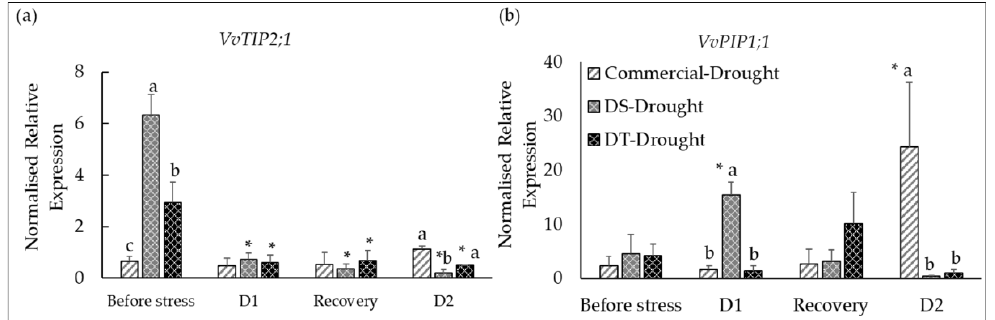
Figure 4. Changes in chlorophyll fluorescence parameters in dry-farmed and commercial clones at the peak of 1st and 2nd drought cycles. ( a ) Mesophyll conductance ( g m ), ( b ) maximum photochemical efficiency ( F v / F m ), ( c ) actual photochemical efficiency (Φ PSII ), ( d ) photochemical quenching coafficient ( qP ), ( e ) non-photochemical quenching (NPQ), and ( f ) electron transport rate (ETR). Values are means ± SEM of six biological replicates. Statistical analysis was conducted using two-way ANOVA. Asterisks indicate statistically significant differences ( p < 0.05) between clones within each drought cycle.